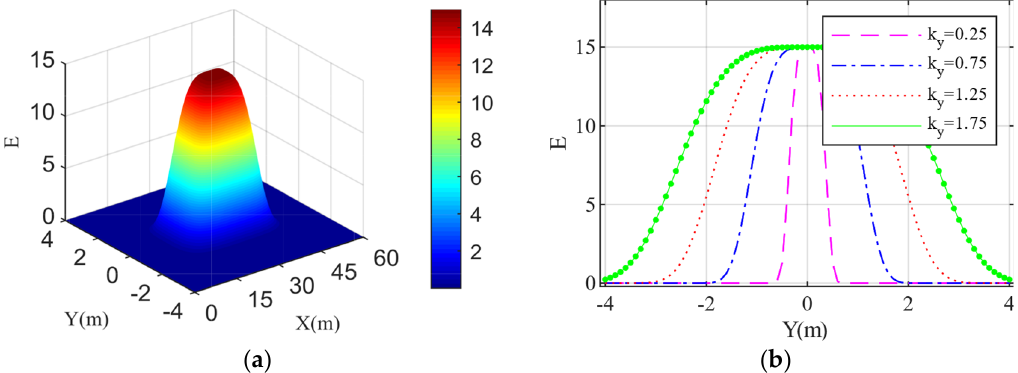
Figure 3. OV’s risk field: ( a ) 3D map of risk field; ( b ) Different coefficients of convergence of an OV’s lateral risk fields exerting on the HV.